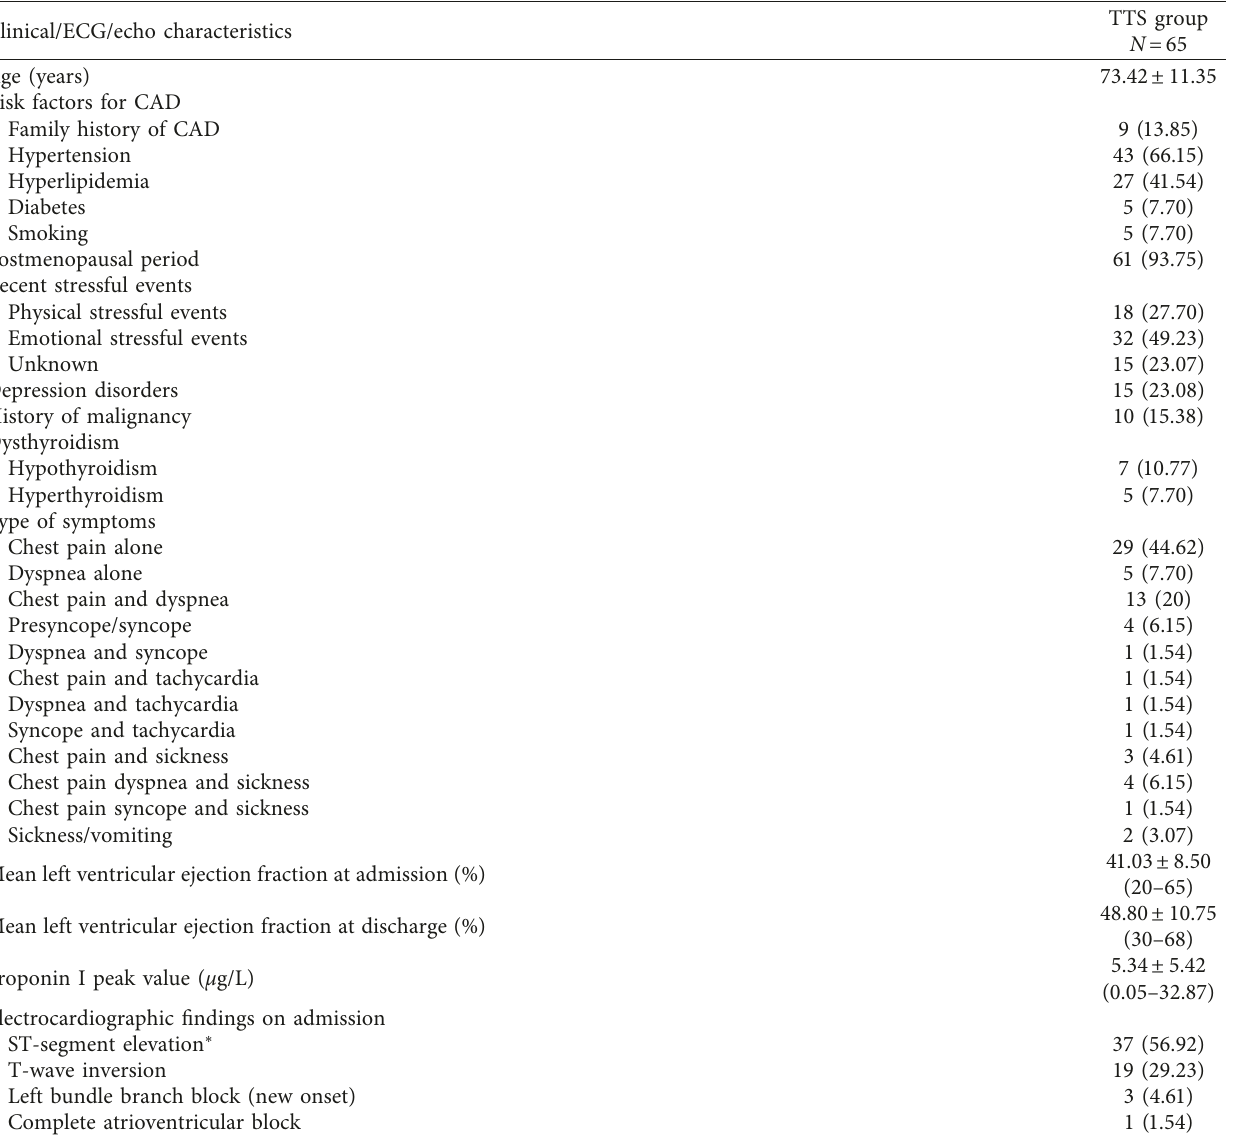
Table 1: TTS patient